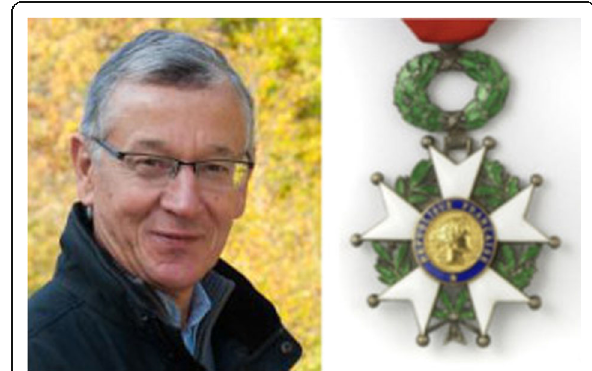
Fig. 21 Francis Martin and the award ’ s medal